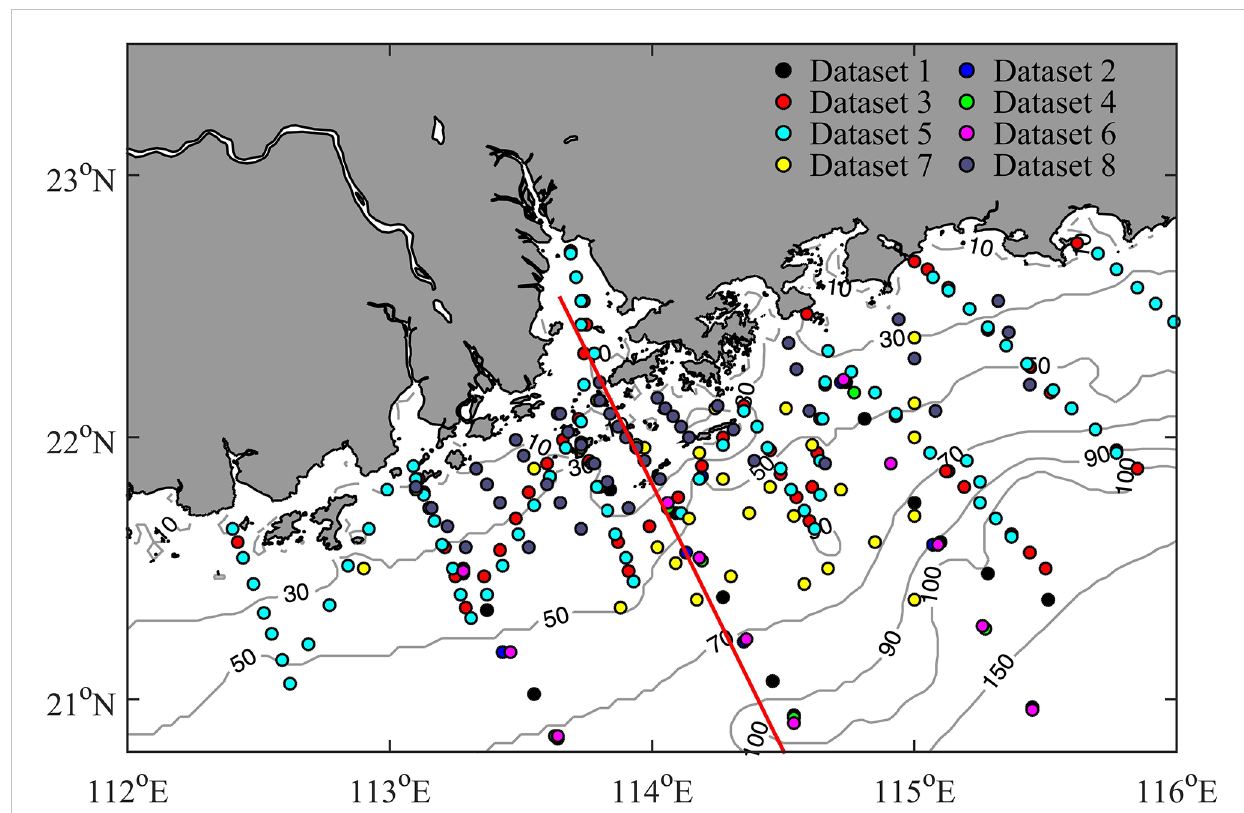
FIGURE 4 Sampling stations on the North South China Sea (NSCS) shelf off the PRE from multiple open cruises. The survey time is listed in Table 1. The red line shows the location of the vertical section in Figures 7, 5, and